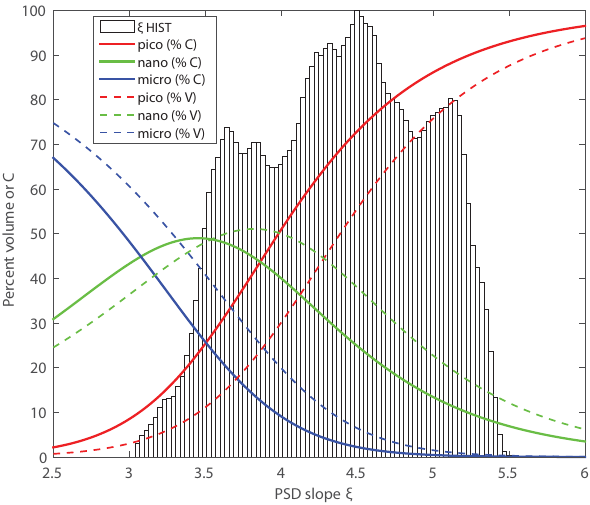
Figure 5. Fractional contribution of the three PSCs, picoplankton (red), nanoplankton (green) and microplankton (blue), to total phy- toplankton carbon biomass (solid lines) and to total biovolume con- centration (dashed lines), as functions of the PSD slope ξ . Limits of integration are the operational limits as indicated in Figs. 3 and 4, and Sect. 2.1.2 (also see Sect. S1.1). Also shown is the histogram of PSD slopes ξ from the mapped image of SeaWiFS mission climatol- ogy (September 1997–December 2010), normalized to the highest count